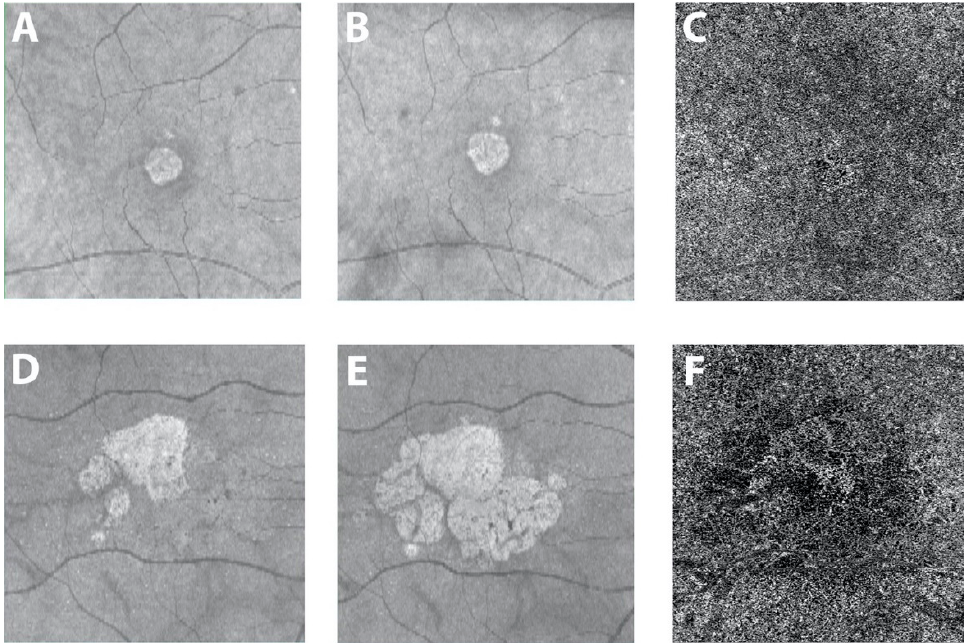
Figure 1. Courtesy of Nassisi et al. 2019: Geographic atrophy and different growth rates: One eye from two patients with geographic atrophy (GA) is shown in the two rows of images. ( A , D ) En face structural optical coherence tomography (OCT) images at baseline. ( B , E ) En face OCT images acquired one year later. The 2 patients show a very different yearly growth rate (0.07 and 0.73 for the first and second row, respectively) of the atrophic lesins. The corresponding OCT angiogram at the level of the choriocapillaris ( C , F ) from the baseline visit for these two patients shows dramatically different flow impairment surrounding the atrophic lesion, with significantly greater flow voids in the case with more rapid progression of atrophy (41.2% versus 53% for ( C , F ) respectively) [73].